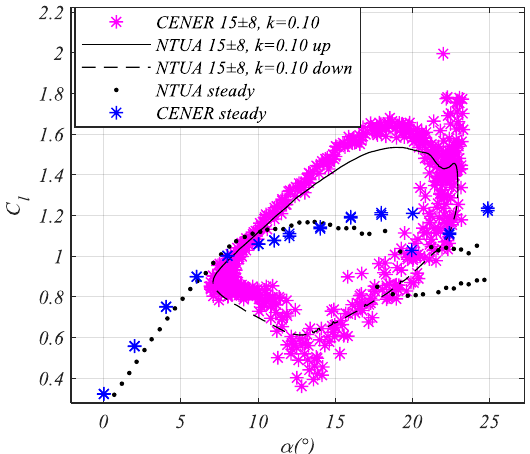
Figure 23. Steady and unsteady lift coefficient (mean angle 15°/amplitude 8°). Comparison with literature data [24].